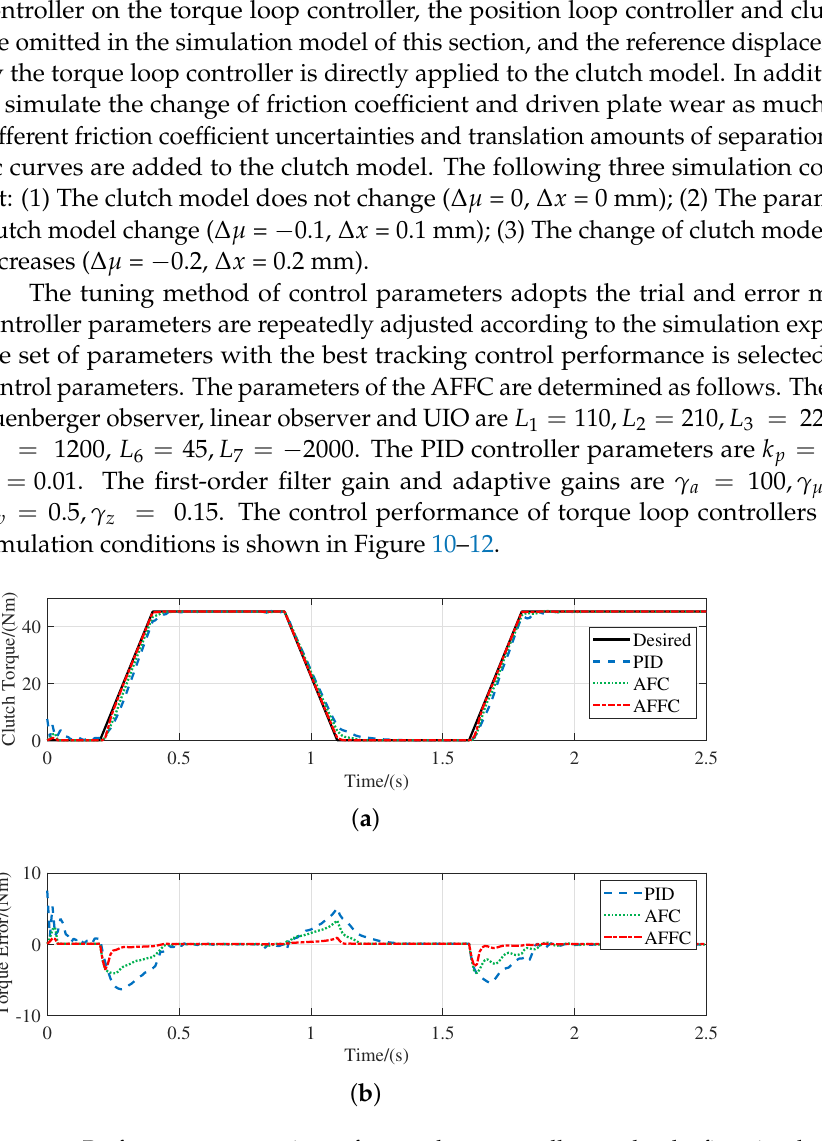
Figure 10. Performance comparison of torque loop controllers under the first simulation condition: ( a ) Clutch Torque; ( b ) Torque